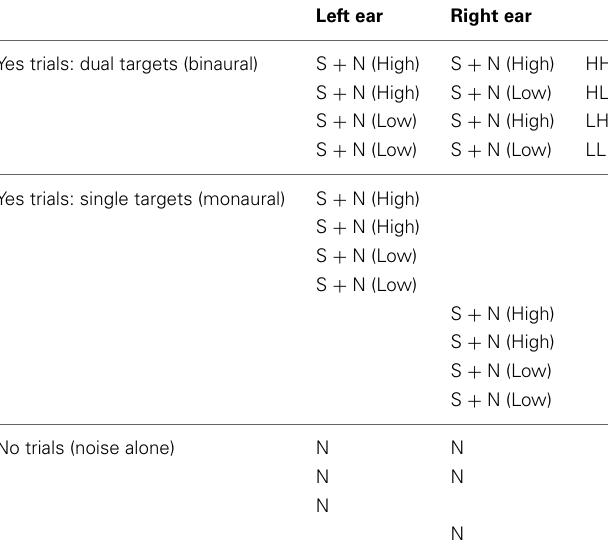
Table 1 | Illustration of stimulus